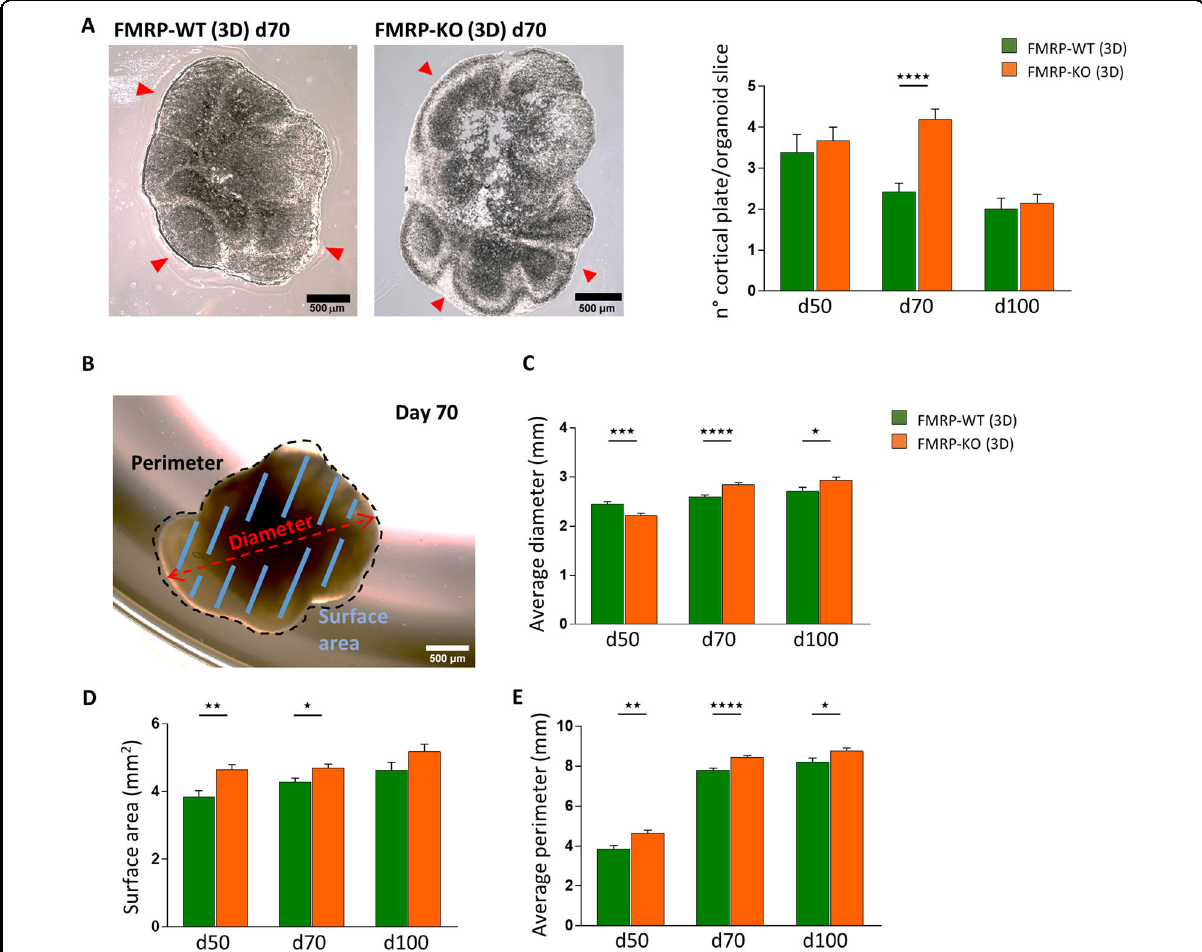
Fig. 7 Quanti fi cation of organoid size parameters at different time points. A Left: Representative slices of FMRP-WT and FMRP-KO cryosectioned brain organoids at day 70 indicating the presence of developing cortical plates (arrows) within the organoids. Right: Bar chart showing the quanti fi cation of cortical plates within FMRP-WT and FMRP-KO brain organoids at day 50 (WT 3.4 ± 0.5, KO 3.6 ± 0.3, p = 0.61, MW test; n = 6/1 WT, n = 5/1 KO organoids/batches), at day 70 (WT 2.4 ± 0.2, KO 4.2 ± 0.3, **** p < 0.0001, MW test; n = 12/3 WT, n = 14/2 KO organoids/batches) and at day 100 (WT 2 ± 0.3, KO 2.1 ± 0.2, p = 0.72, MW test; n = 8/1 WT, n = 9/1 KOorganoids/batches). B Representative tracing of organoid maximum diameter, perimeter, and surface area at day 70. The quanti fi cation of the organoid size parameters was performed at day 50, 70, and 100. C Bar chart showing organoid diameter (day 50 *** p < 0.001: WT n = 48/1, KO n = 41/1 organoids/batches; day 70 **** p < 0.0001: WT n = 110/3, KO n = 102/2 organoids/batches; day 100 * p < 0.05: WT n = 21/1, KO n = 22/1 organoids/batches. D Bar chart showing organoid surface area (day 50 ** p < 0.01; day 70 * p < 0.05; day 100, p = 0.1; n as in C ). E Bar chart showing organoid perimeter (day 50 ** p < 0.01; day 70 **** p < 0.0001; day 100, * p < 0.05; n as in C